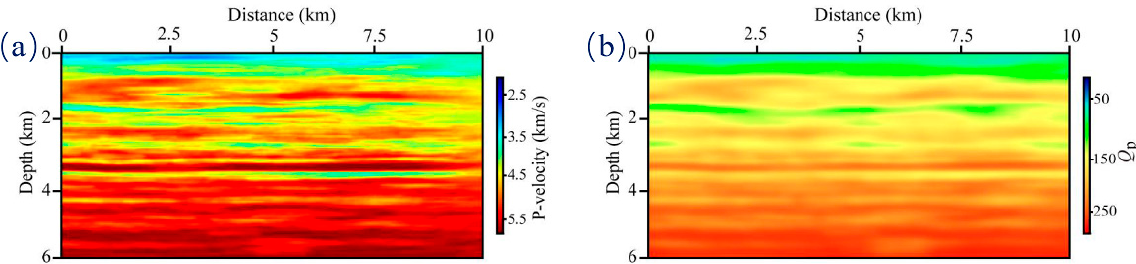
Figure 10. The ( a ) P-wave velocity and ( b ) quality factor Q p models correspond to the field data.